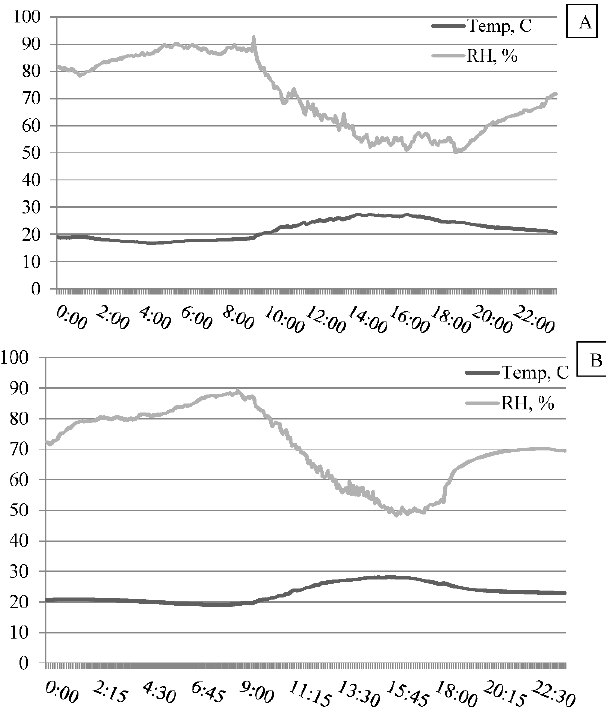
Figure 4. Daily temperature and relative humidity in Arusha, Tanzania, plotted on a 24 h basis on two of the trial days, ( A ) 25 February 2014 and ( B ) 26 February